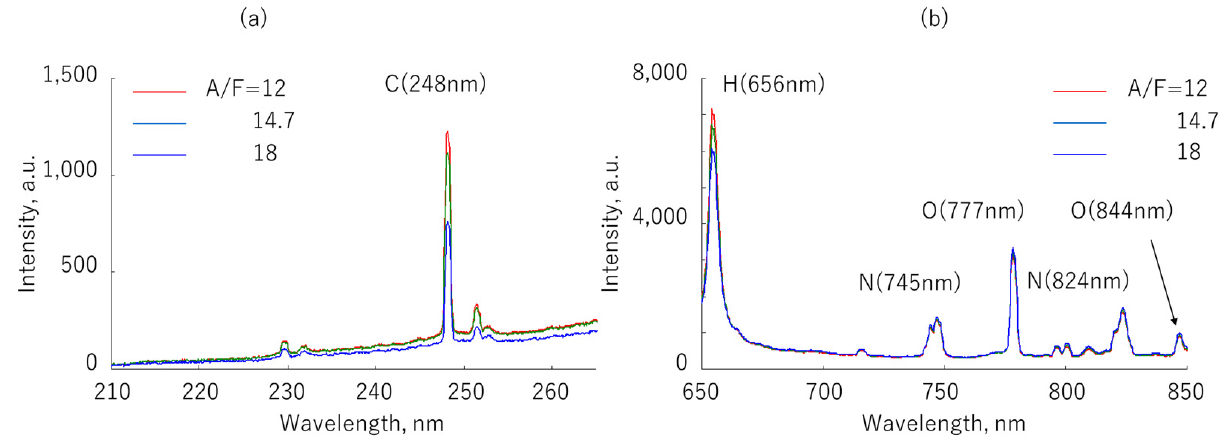
Figure 12. ( a ) C and ( b ) H, N, and O atomic spectra (A/F = 12, 14.7, 18). The C and H atomic spectra significantly decrease with higher A/F values.